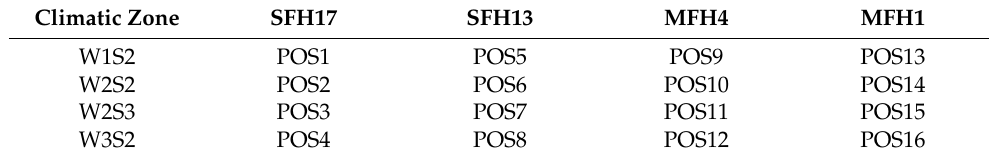
Table 2. Type of POS according to the climatic zone and type of reference building. Climatic Zone